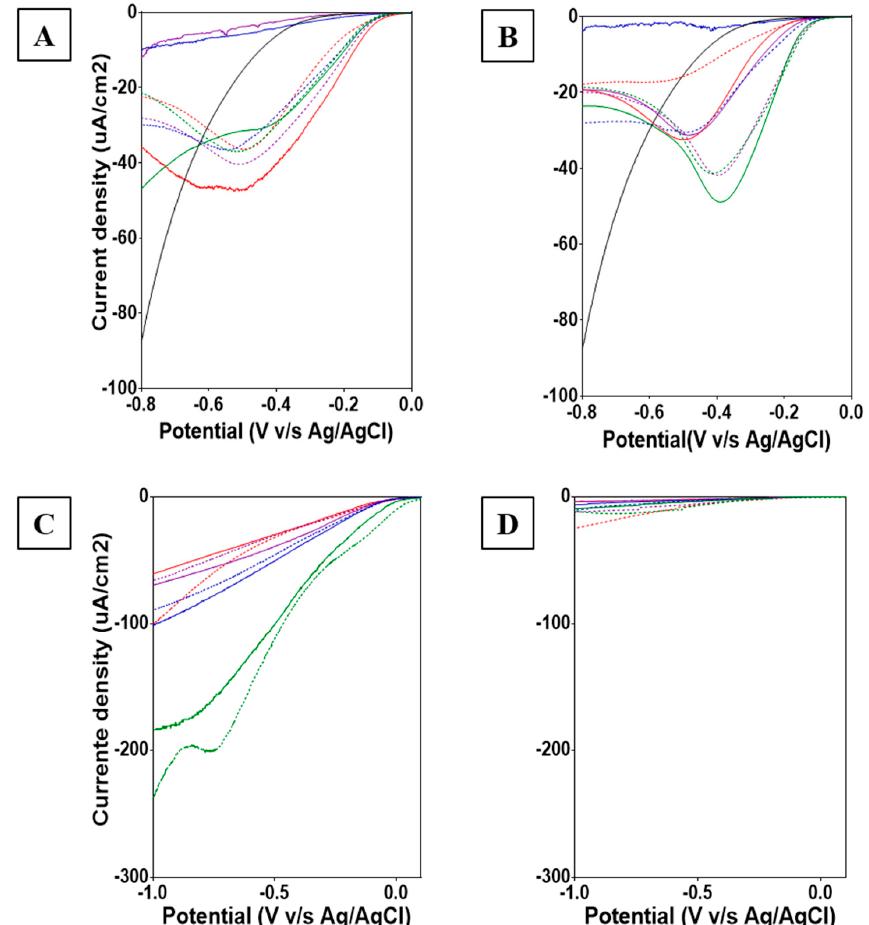
Figure 3. Linear Sweep Voltammetry (LSV) for electrodes from BES after 15 months. ( A ) Cathodes connected to graphite anode. ( B ) Cathodes connected to titanium anodes. ( C ) Graphite anodes. ( D ) Titanium anodes. Colors were used to represent each system with anodes at different depths: red 7.5 cm, purple 12 cm, blue 15.5 cm, and green 21 cm. Continue lines were used for column 1 (BC1) and discontinue lines for column 2 (BC2).